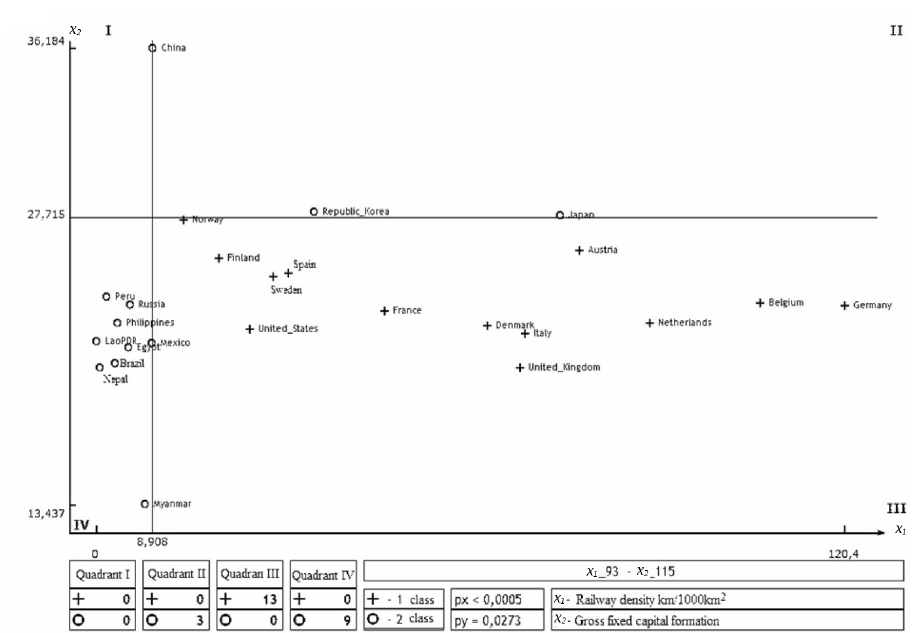
Figure 2. Two-dimensional regularity describing the dependence of the institutional type on the railway density and